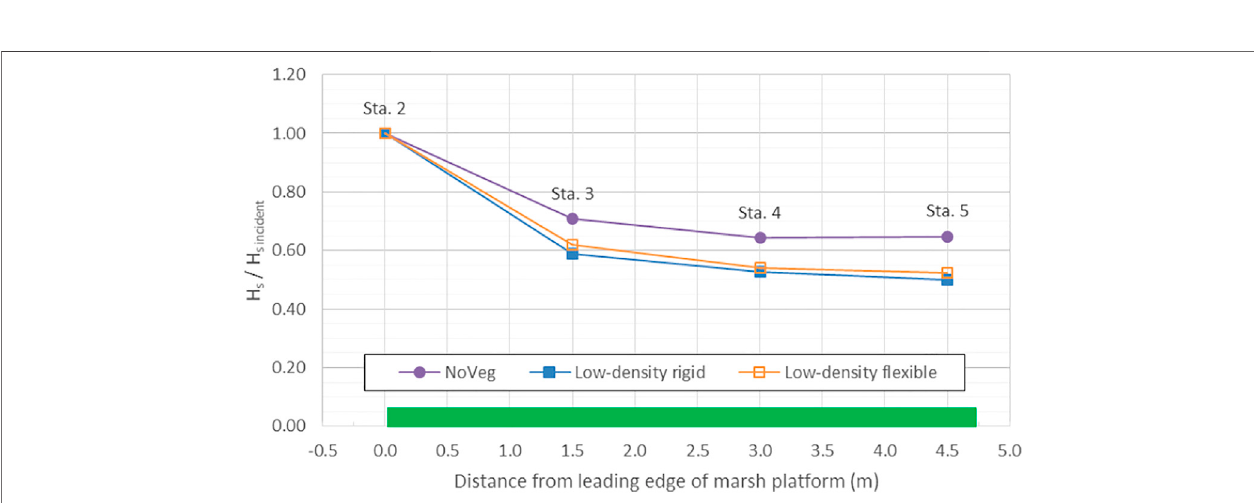
FIGURE12| Waveattenuationacrosssimilararti fi cialmarshescomprisedofrigidand fl exiblevegetation.Dataisnormalizedbytheincidentwaveheightattheedge of the marsh (@ Station 2). Note that this fi gure includes wave height attenuation due to depth-limited breaking.